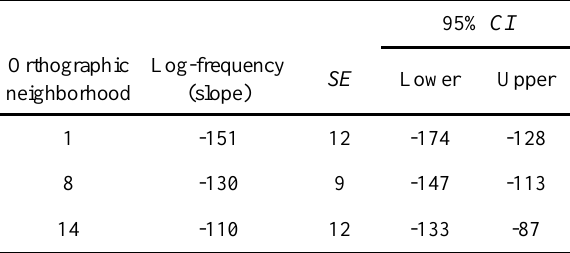
Table A7. Total reading time per word: Interaction of lexical frequency and orthographic-neighborhood size.